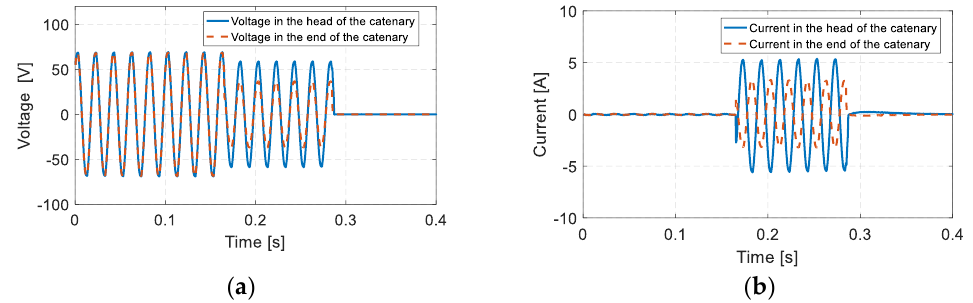
Figure 19. Voltage and current in the catenary at the AT subsection 1: ( a ) Voltage in two terminals of the catenary and ( b ) current in two terminals of the catenary.